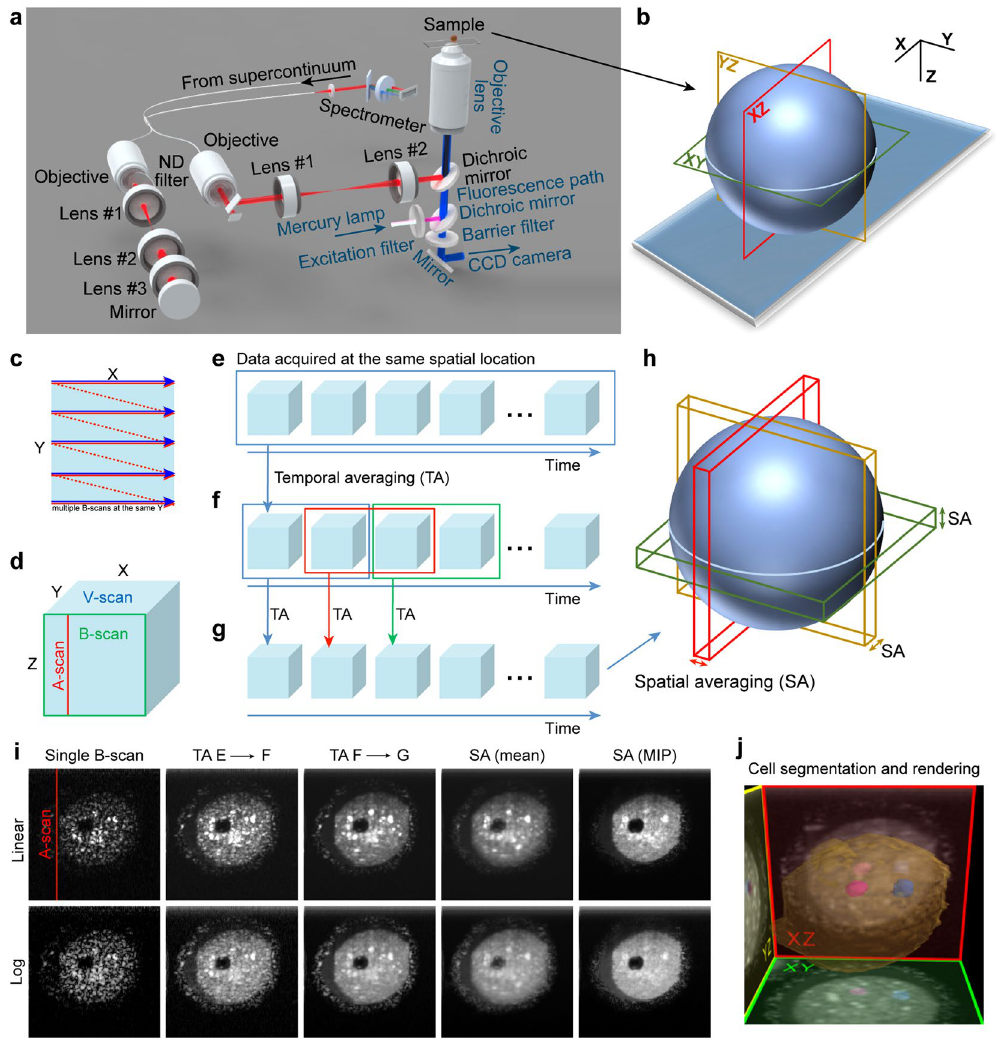
Figure 1. The OCM system and experimental layout. ( a ) Imaging setup: the original parts of the inverted microscope are marked in blue and custom OCM parts in black. ( b ) Schematic of image cross-sections obtained with the OCM setup. ( c ) OCM beam trajectory in the XY plane. Solid line: the beam trajectory during data acquisition. Dotted line: the beam trajectory between Y positions. ( d ) Schematic of the data volume acquired in a single OCM measurement. The A-scan is a single image line obtained from one OCM data acquisition. The B-scan is a single image generated from the A-scans. The V-scan is generated from the B-scans acquired at different Y positions. ( e – g ) Stages of the diversified time interval scanning protocol (DTIsp). ( e ) Several V-scans are acquired within ~1 sec and undergo temporal averaging. ( f ) The averaged V-scans from ( e ) were acquired continuously with a time span ranging from ~20–600 sec for periods of tens of hours. ( g ) Temporal averaging (TA) was performed on the averaged V-scans from ( f ) to obtain images with reduced speckle noise. ( h ) Optional spatial averaging (SA) over thick slices of the averaged V-scan. Different types of averaging are possible, including intensity averaging (mean), minimal or maximal intensity projections (MIP). ( i ) Images from consecutive steps of DTIsp processing. Linear intensity mapping allows for a better visualization of the cytoplasmic features, while logarithmic - of the nuclei. ( j ) Cell segmentation and